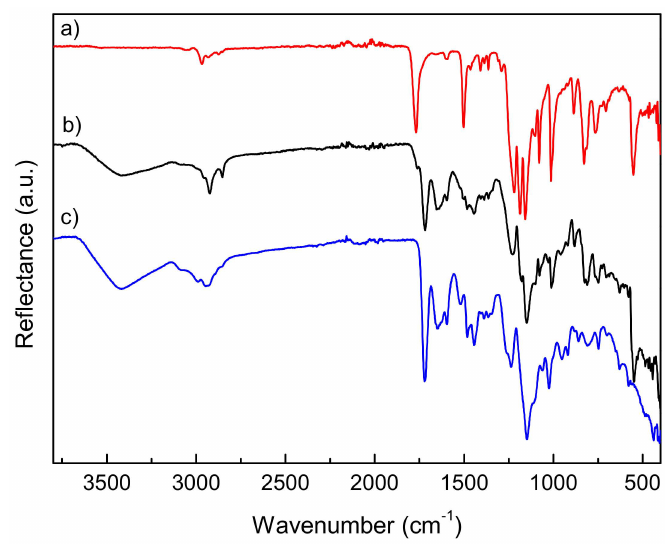
Figure 5. ATR-FTIR spectra of ( a ) PC substrate, ( b ) P(DOMA 24 - co -MTA 76 )M coated on PC substrate, and ( c ) P(DOMA 24 - co -MTA 76 )M